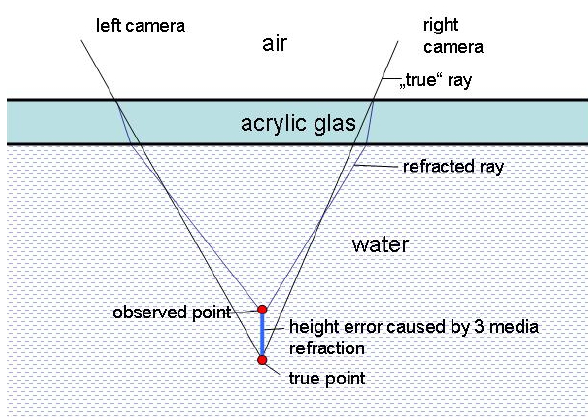
Figure 6. Three media refraction and point displacement